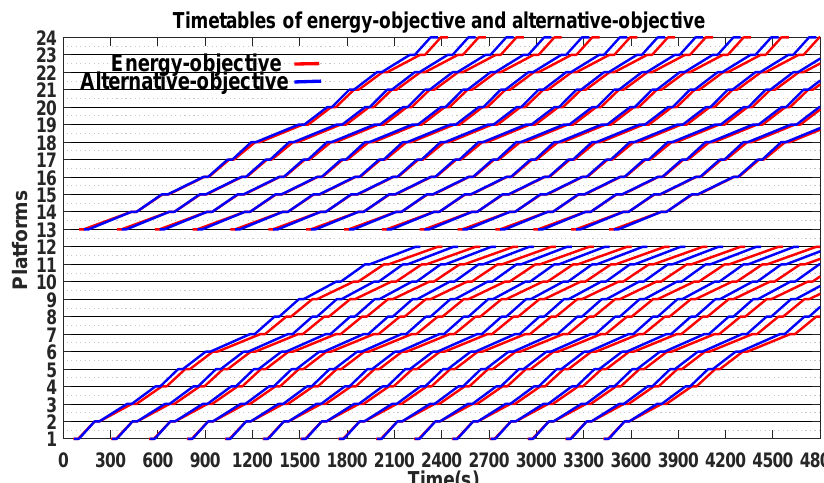
Figure 15. Timetables with two different